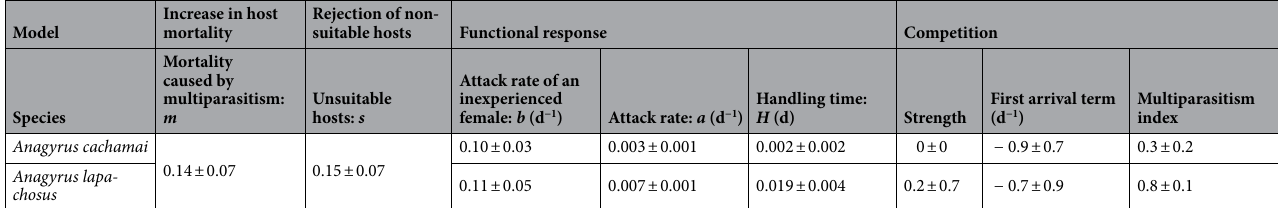
Table 3. A posteriori mean ± standard deviation of the species-specific parameters of the selected models for two parasitoids, Anagyrus cachamai and A. lapachosus , attacking Hypogeococcus sp. Parameter calculation was averaged for the eight selected models based on their optimal balance between explanatory power and complexity. Physical units of the calculated parameters: d days, parameters without units are